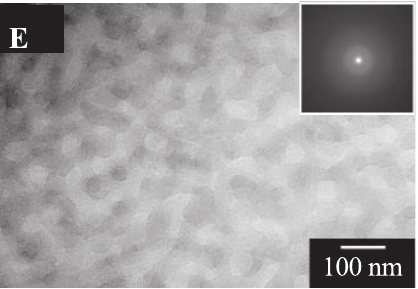
Table 1: Composition dependence of microstructures formed by phase separation in SiO -CaO-MgO-Na O glass. (Annealing 2 2 condition: 948 K, 192 h) [2]